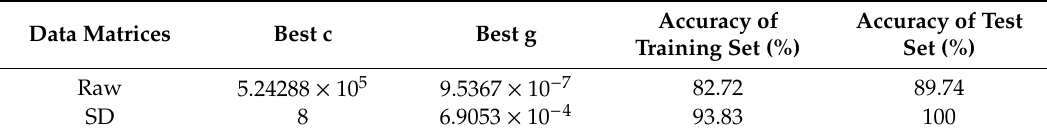
Figure 4. Actual and predicted category results of test samples by SVM. ( a ) Raw, ( b ) SD. Table 1. Results of SVM models for recognizing di ff erent species of Lingzhi basing on di ff erent data